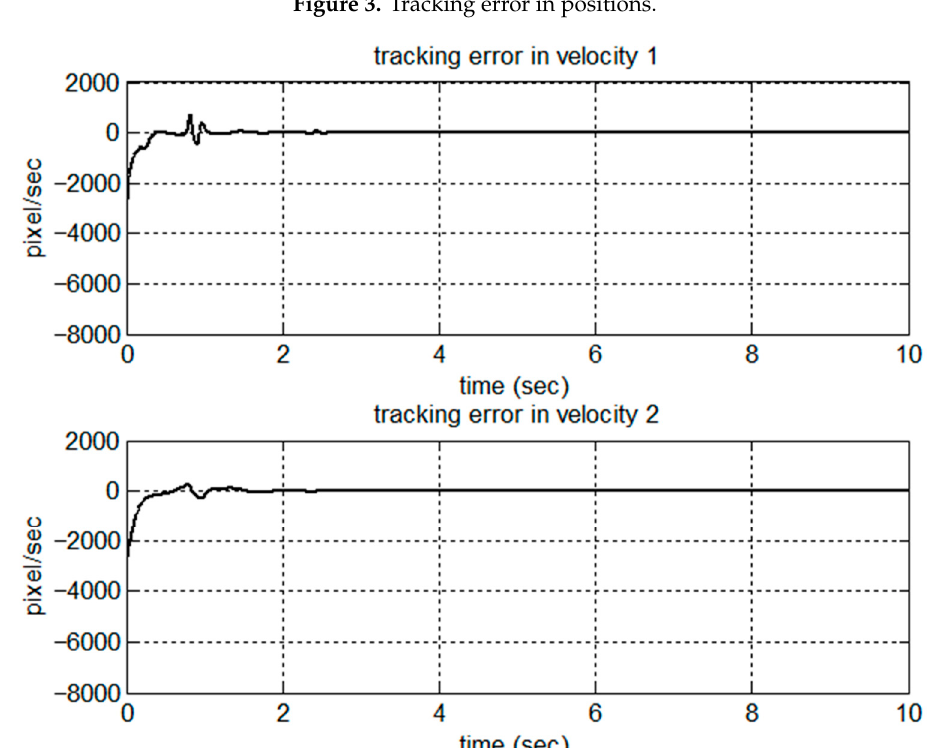
Figure 4. Tracking error in velocities.